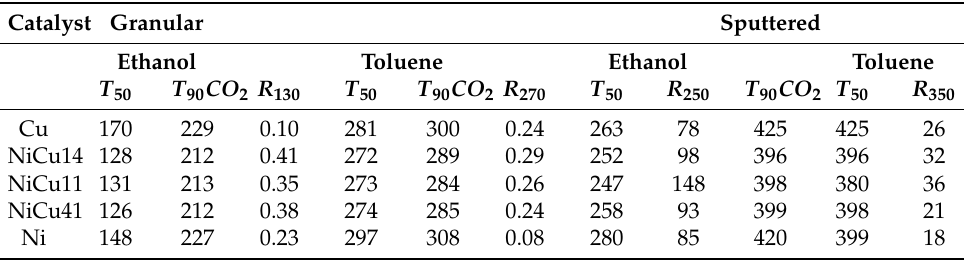
Table 7. Temperatures T 50 and T 90 CO , °C, and specific reaction rate R T observed in the oxidation of ethanol and toluene over granular and sputtered catalysts. Reaction conditions: 0.2 g of granular catalyst or 3.8 g of sputtered catalysts, 760 ppm of ethanol or 780 ppm of toluene, GHSV 21 L g cat−l h −l , temperature ramp 2 °C min −l .